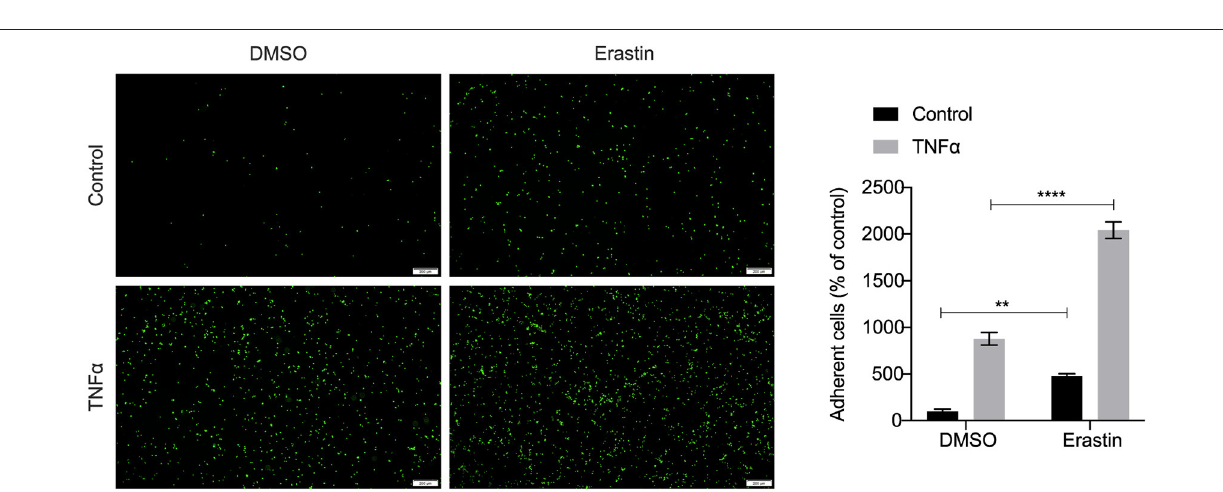
FIGURE 8 | expression levels among different immune subtypes (E,F) . Differences in the levels of immune cells (memory B cells, CD8 + T cells, regulatory T cells (Tregs), activated NK cells, M0 macrophages, activated memory CD4 + T cells, and Monocytes) among the HMOX1 high- and low-expression groups (G,H) . Different M0 macrophages infiltration levels among the HMOX1 high- and low-expression groups [ (I) analysis of all atherosclerosis samples in GSE28829; (J) analysis of all 64 samples in GSE43292; (K) analysis of 32 atherosclerosis samples in GSE43292). Correlation analysis between HMOX1 expression and M0 macrophage levels among